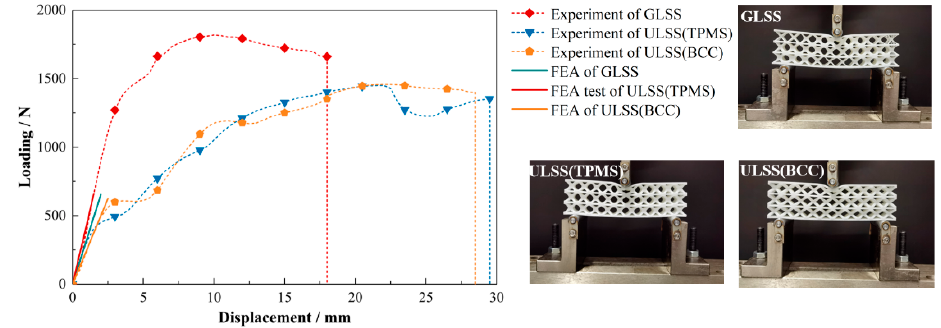
Figure 21. Loading and displacement curves from three-point bending tests of the printed LSSs.